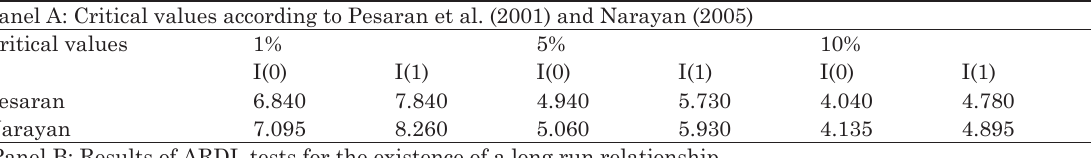
Panel B: Results of ARDL tests for the existence of a long run relationship